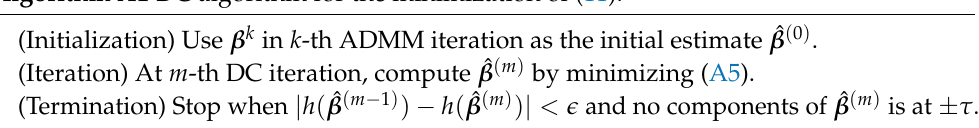
Algorithm A1 DC algorithm for the minimization of